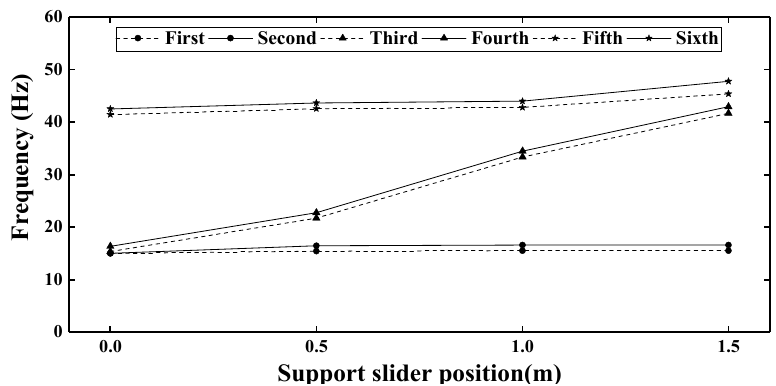
Figure 6. The natural frequency of the lead screw with the support slider.